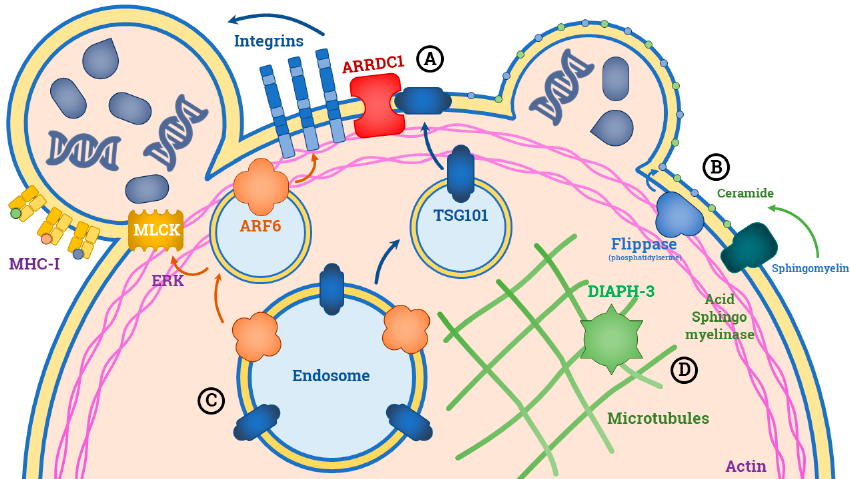
Figure 1. Principal mechanisms involved in the biogenesis of large extracellular vesicles (L-EVs). Many pathways are involved in L-EVs’ generation. ( A ) The Arrestin Domain-Containing Protein-1 (ARRDC1) induces the relocalization of TSG101 from the endosomal compartment to the plasma membrane, thus provoking shape changes in the cell membrane curvature that initiate the microvesicle gemmation. ( B ) Similar membrane plasticity modifications depend on the translocation of phosphatidylserine on the outer membrane layer or by the acid sphingomyelinase-mediated